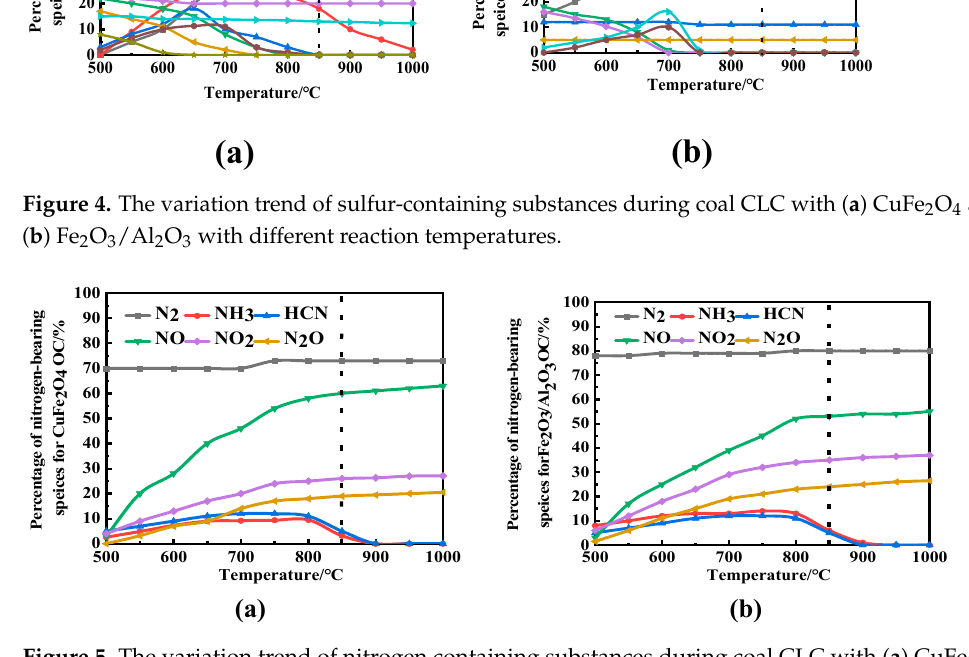
Figure 5. The variation trend of nitrogen containing substances during coal CLC with ( a ) CuFe 2 O 4 and ( b ) Fe 2 O 3 /Al 2 O 3 with different reaction temperatures .